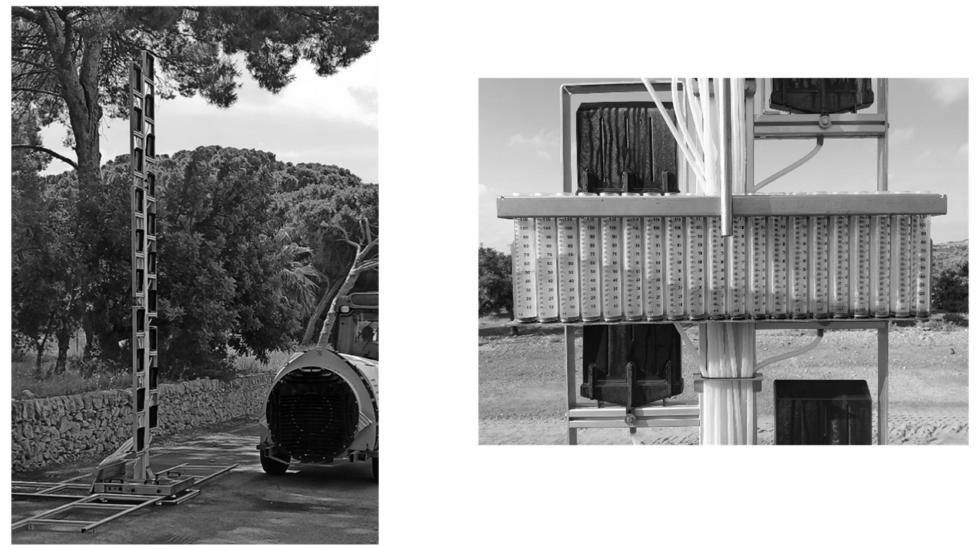
Figure 6. Vertical spray profile distribution evaluation system ( left ). Cylinders where the spray collected by height accumulates ( right ).